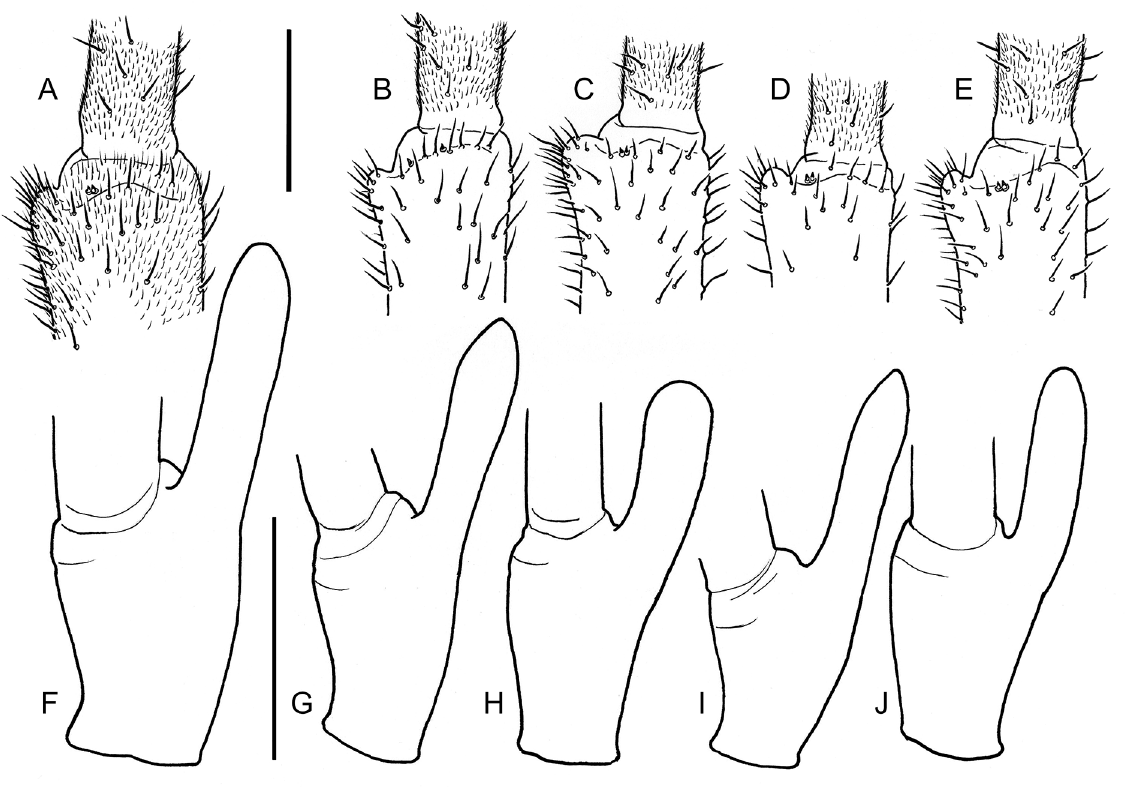
Fig. 6. Details of male right pedipalps. A – E . Dorsal view of mediodistal apophysis on tibia. F – J . Ventral view of patella (setae omitted). A , F . Dicranopalpus insignipalpis (Simon, 1879) (CJM 7258). B , G . D. cantabricus Dresco, 1953 (ZUPV 4542). C , H . D. gallaecicus sp. nov. (CHW 491). D , I . D. pyrenaeus Dresco, 1948 (CJM 2649). E , J . D. catariegensis sp. nov. (CHW 469). Note the two sensilla basiconica, mostly occurring paired, near the distal margin of the tibia (A–E; see also BA in Fig. 3). Scale bar: A–E = 0.25 mm; F–J = 0.5